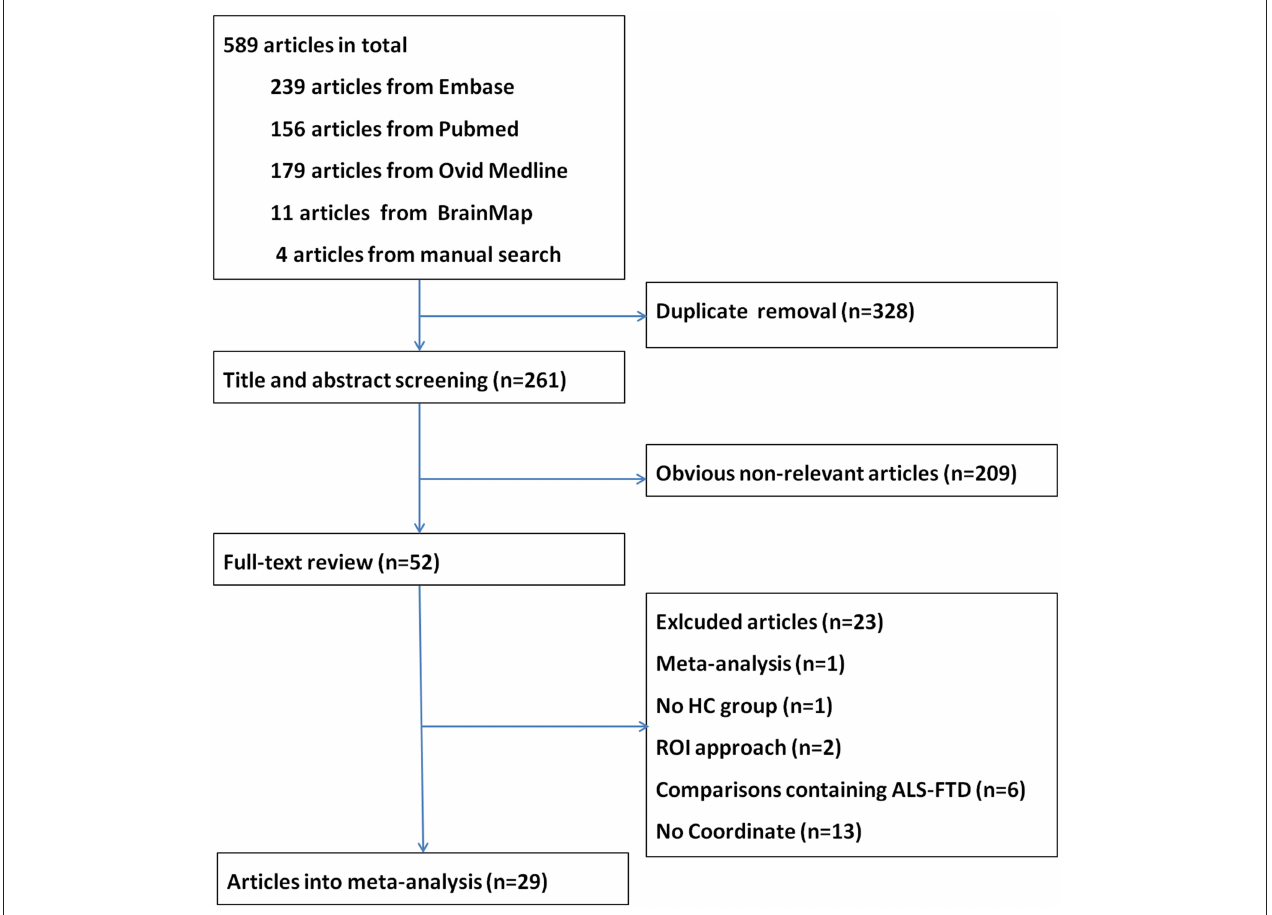
FIGURE 1 | The flow chart of the literature search in the